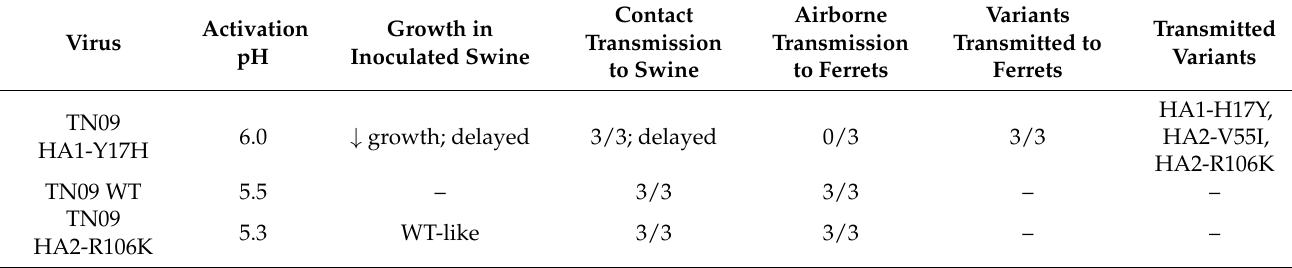
Table 6. A/Tennessee/1-560/2009 (H1N1) HA stability variants in swine and co-housed ferrets [173].